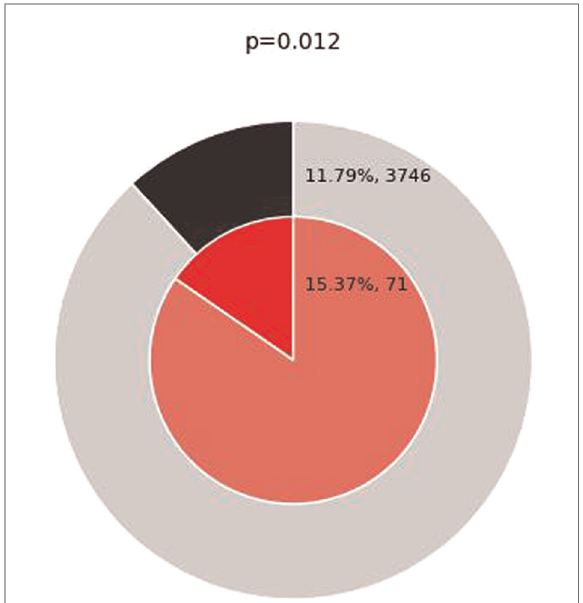
FIGURE 7 Enrichment of genes matching membership term: in fl ammation. The outer pie shows the number and the percentage of genes in the background that are associated with the in fl ammation (in black); the inner pie shows the number and the percentage of genes in the brown module gene list that are associated with the in fl ammation. The P -value indicates whether the membership is statistically signi fi cantly enriched in the brown module gene